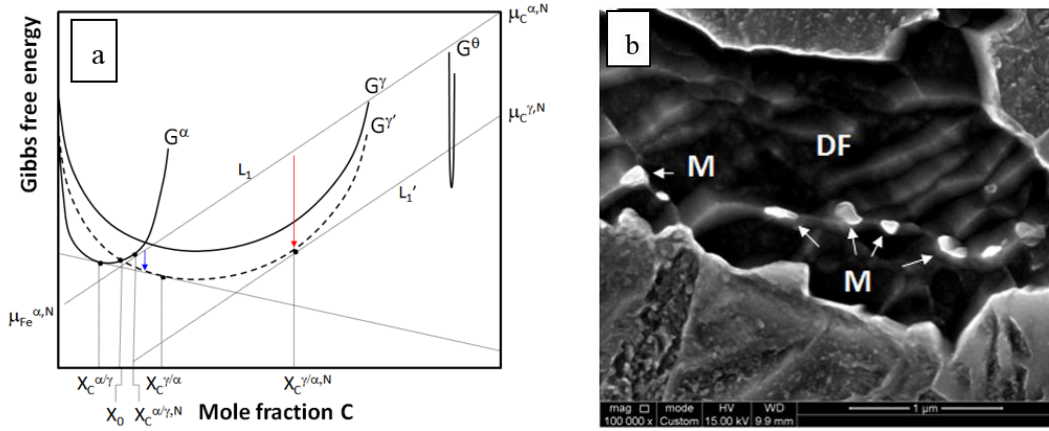
Figure 3. ( a ) Scheme of a Gibbs free energy G versus composition (in mole fraction) plot for a temperature slightly above the eutectoid (solid lines) and much above the eutectoid (dashed line). G α , G γ , and G θ respectively represent the Gibbs free energy of ferrite, austenite, and cementite. L 1 and L 1 ′ are common tangents determining the driving force for austenite nucleation from ferrite; ( b ) is an SEM image of a sample heated at 1500 °C/s to 862 °C and quenched. White arrows show the nucleation of austenite (martensite, M) at the α/α grain boundaries in deformed ferrite (DF). Etched with Nital 4%.